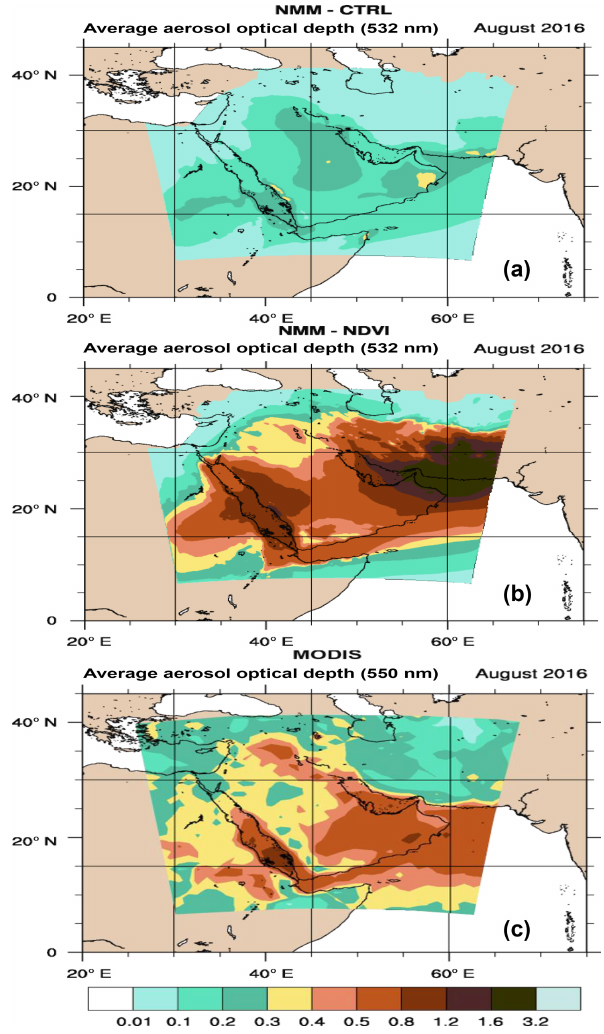
Figure 4. Monthly average simulated AOD during August 2016 from the DREAM-CTRL run (a) , the DREAM-NDVI run (b) and (c)